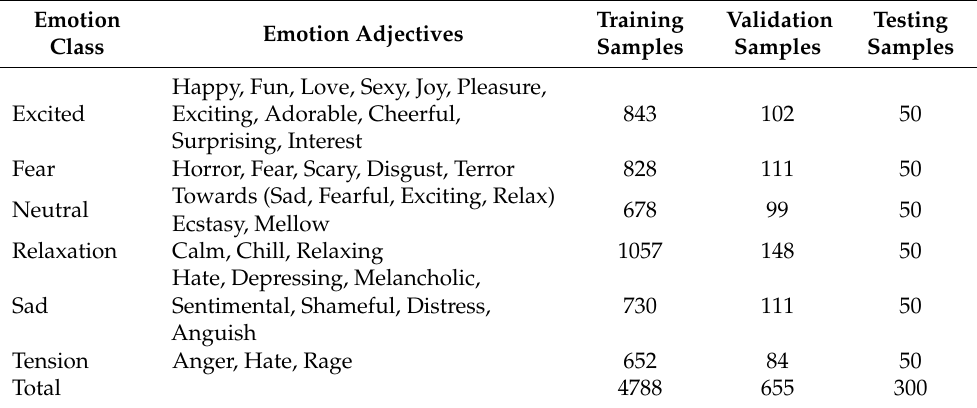
Table 1. Music video dataset with various adjectives and statistics in each emotion